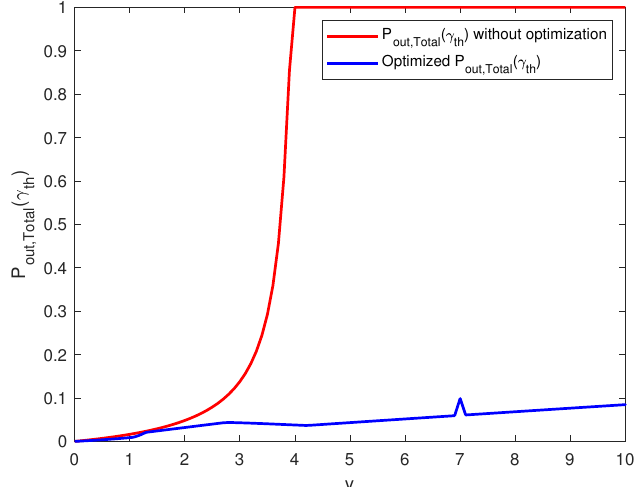
Figure 6. Performance of outage probability minimization via Task